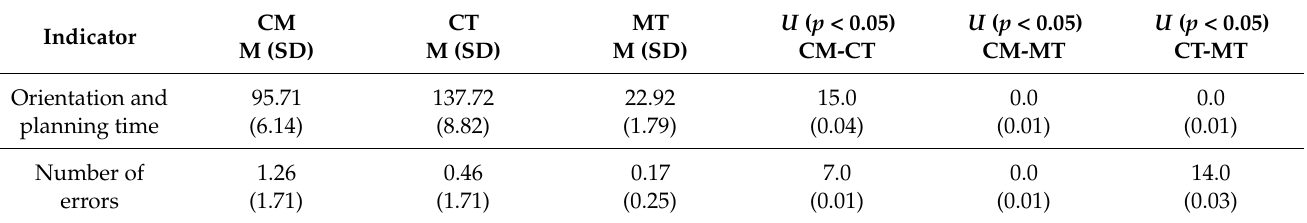
Table 4. Orientation and planning time and the number of errors comparison during the whole training.